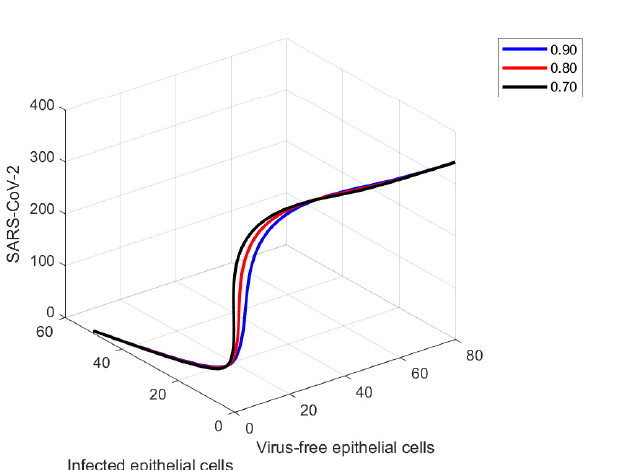
Figure 9. Graphical representation of the SARS-CoV-2, virus-infected epithelial cells, and virus-free epithelial cells of approximate solutions for fractional order α = 0.9, 0.8,